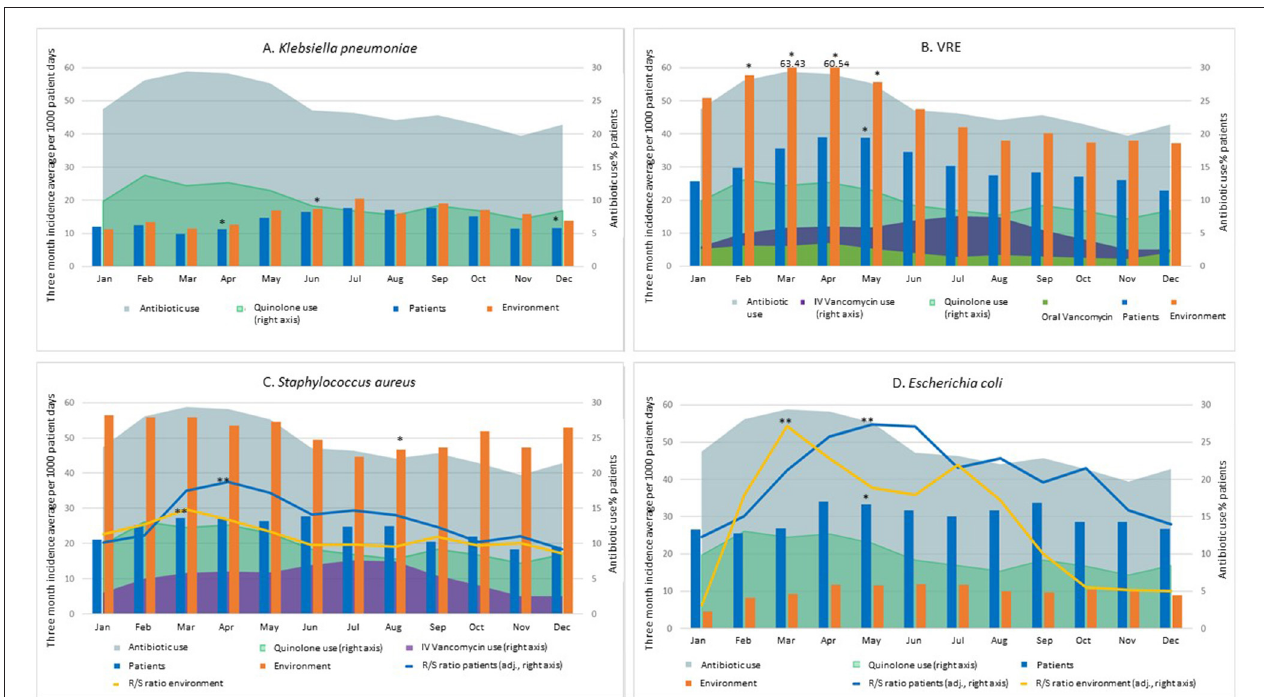
FIGURE 1 | Seasonal incidence (3-month moving average) of patient and environmental isolates of K. pneumoniae (A) , VRE (B) , S. aureus (C) , and E. coli (D) . For S. aureus , the ratio of MRSA to MSSA isolates is also shown. For E. coli , the ciprofloxacin resistant to susceptible ratio is shown. Monthly facility usage of all antibiotic, ciprofloxacin and IV vancomycin (VRE and S. aureus ) is also provided. Spring: March 1st–May 31st. Summer: June 1st–August 31st. Fall: September 1st–November 30th. Winter: December 1st–February 28th. The scale for the Resistant to Susceptible (R/S) ratio for S. aureus (C) is 1/10th of the right Y axis scale, for improved visibility. * p < 0.05 difference in single-month incidence compared to the arbitrary selected reference month (September) (logistic regression with categorical predictors). ** p < 0.05 difference between peak and trough in the Resistant-to-Susceptible (R/S) ratio (linear regression and Pearson’s correlation